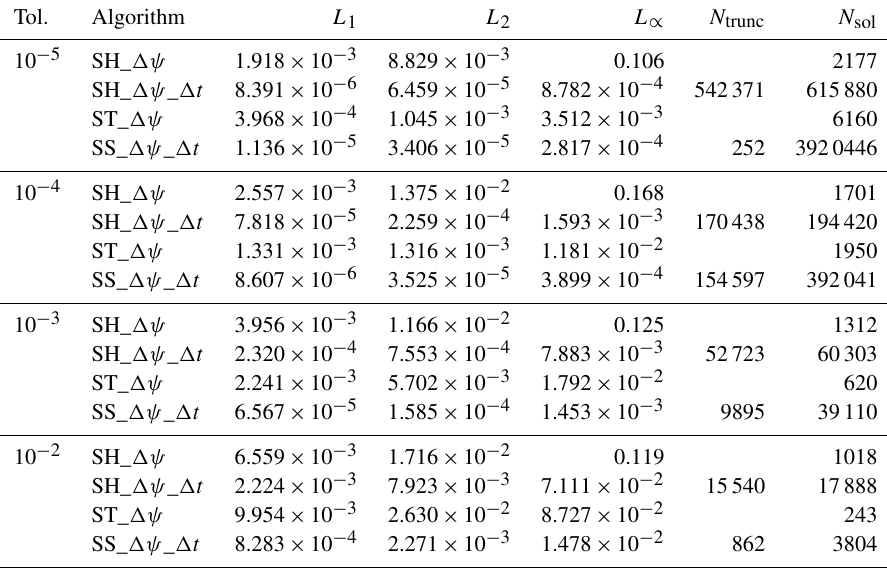
Table 3. Relative errors and number of iterations obtained for the iterative algorithm depending on different convergence criteria for TC1. Tol.